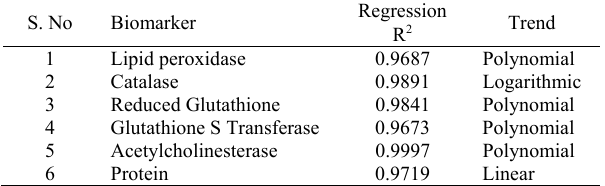
Table 1: Regression analysis of the effects of hypercapnia on biomarkers and protein S. No